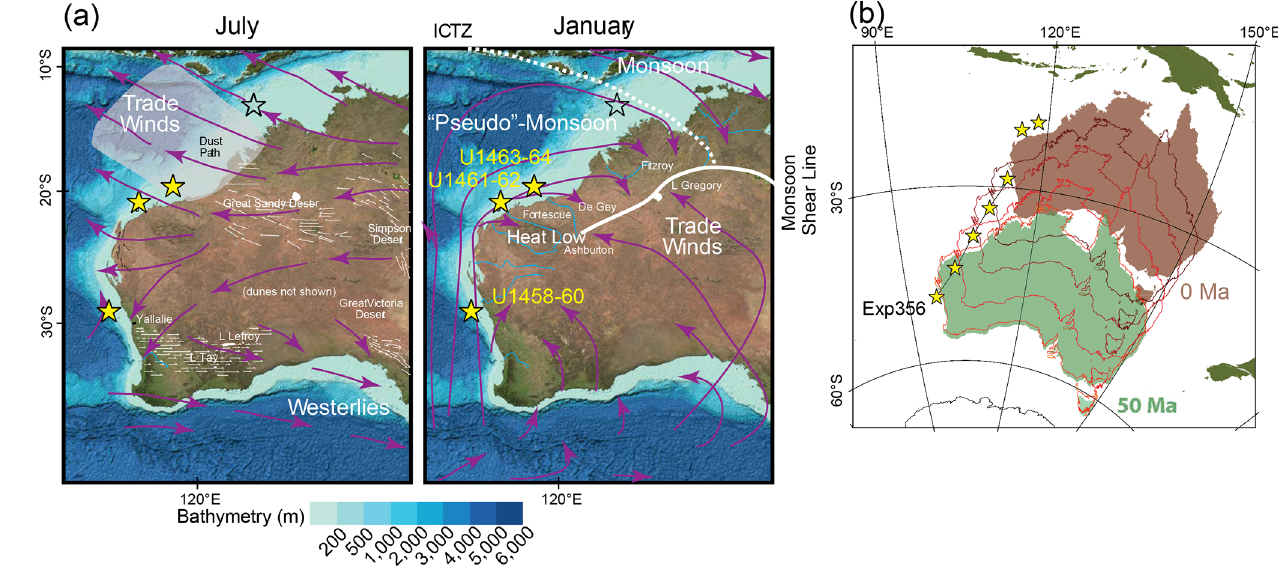
Figure 9. (a) Atmospheric circulation for January and July (Gentilli, 1972) with the mean monsoon shear line (McBride, 1986) and in- tertropical convergence zone (ITCZ). Base map adapted from the General Bathymetric Chart of the Oceans (GEBCO) http://www.gebco.net (last access: 29 May 2022). IODP Expedition 356 sites are shown as stars. (b) Plate tectonic motion of Australia since 50Ma at 10Myr intervals, with the path line for Site U1459 (Expedition 356). Figure adapted from Gallagher and deMenocal